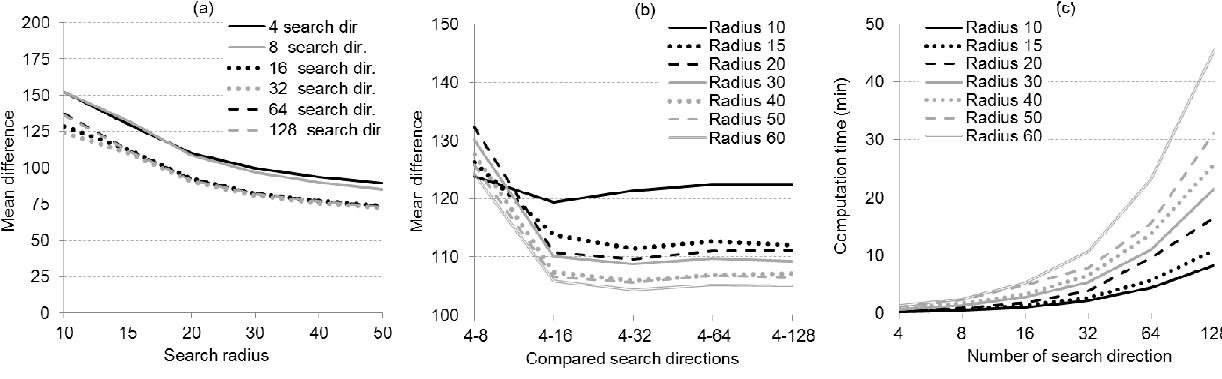
Figure 9. Sky-view factor parameter tests: ( a ) mean difference according to search radius value for difference search direction, ( b ) mean difference according to the number of search direction for difference search radius values, ( c ) computation time required depending on the number of search directions and search radius